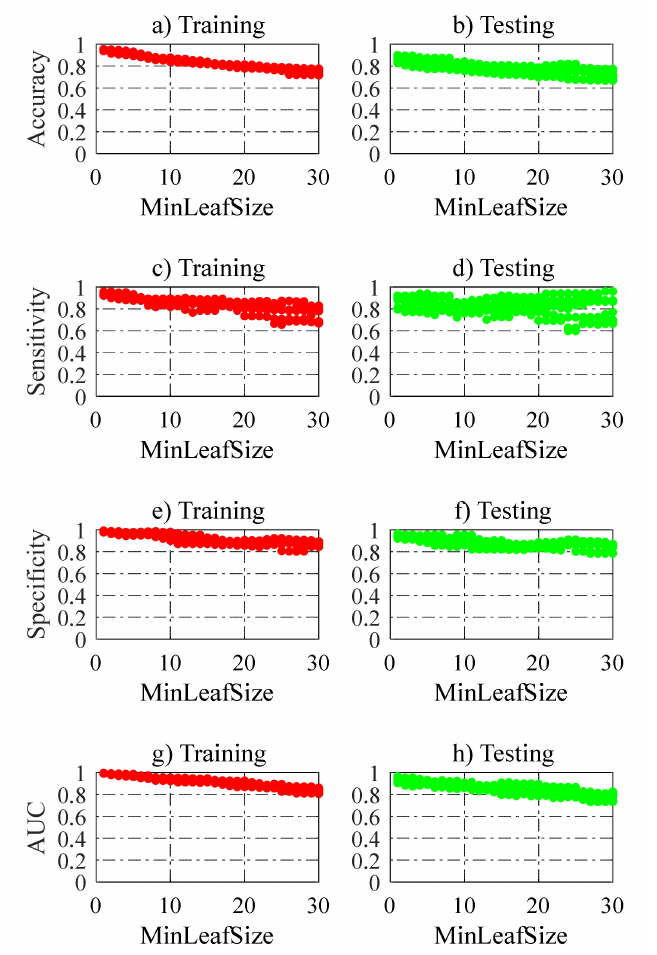
Figure 14. Performance of 210 DT models for classifying failure